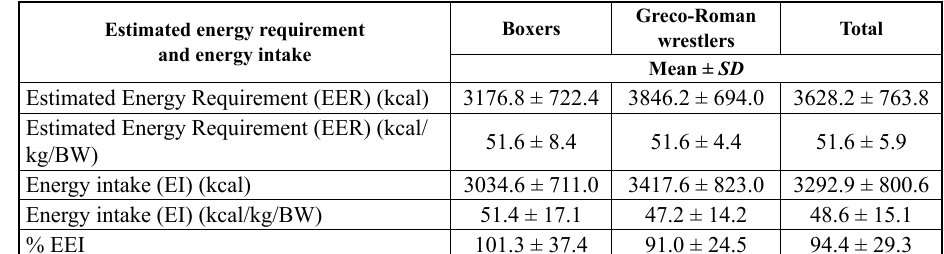
Note. BW – body weight.